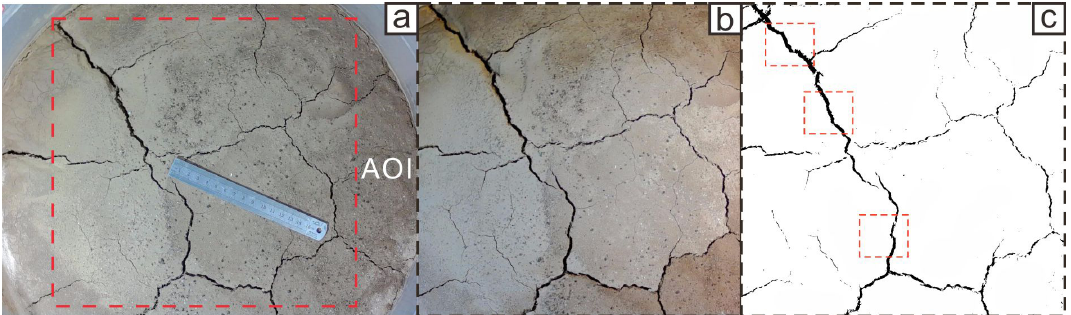
Figure 3. Process of crack image processing. (a) A photo obtained from the HD camera, 800 pixels × 1400 pixels. (b) A crack image after cropping and pixel enhancement, 1044 pixels × 1005 pixels. (c) A crack image after binarization and denoising; the crack ratio was calculated as the crack area divided by the overall area of interest, and the crack aperture was calculated as the average value of crack aperture from three different positions.